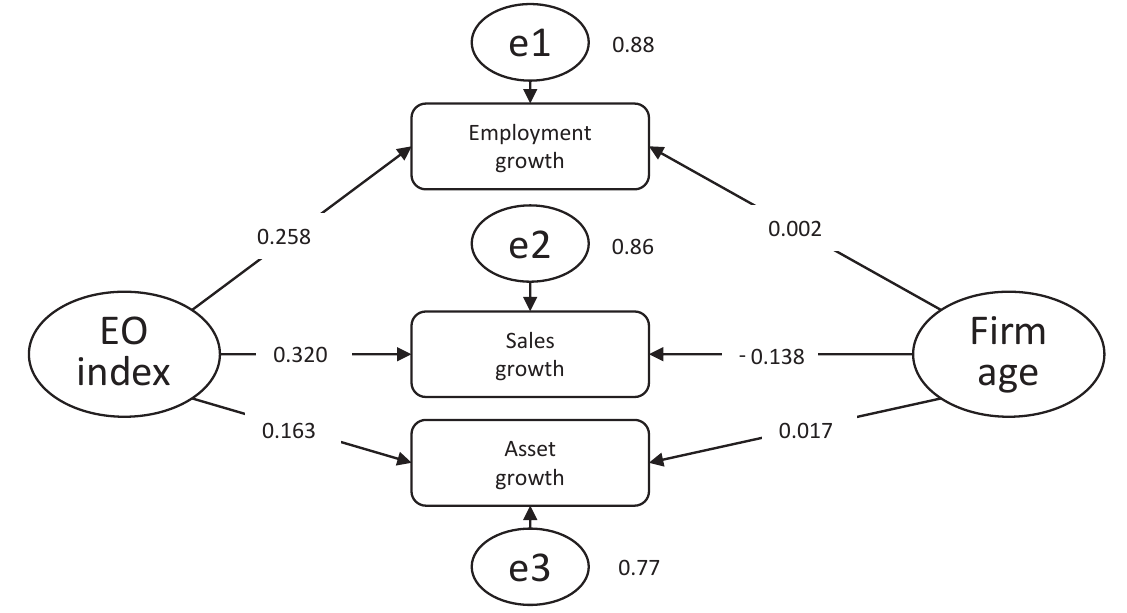
Figure 1. Structural Equation Model (SEM) Path Diagram between Firm Growth and EO index